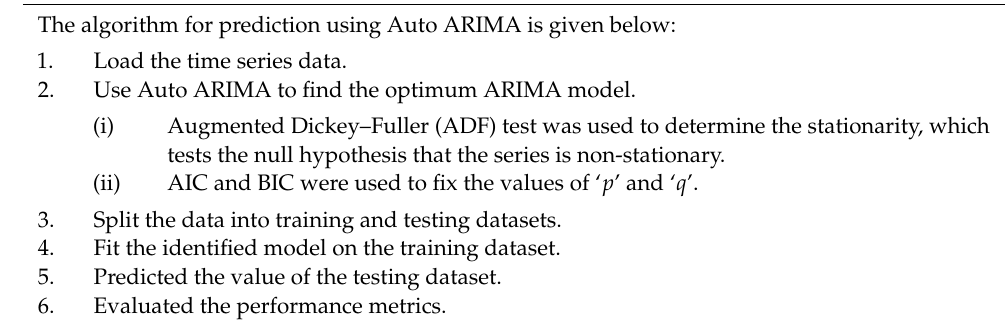
Algorithm 1: Auto ARIMA prediction model